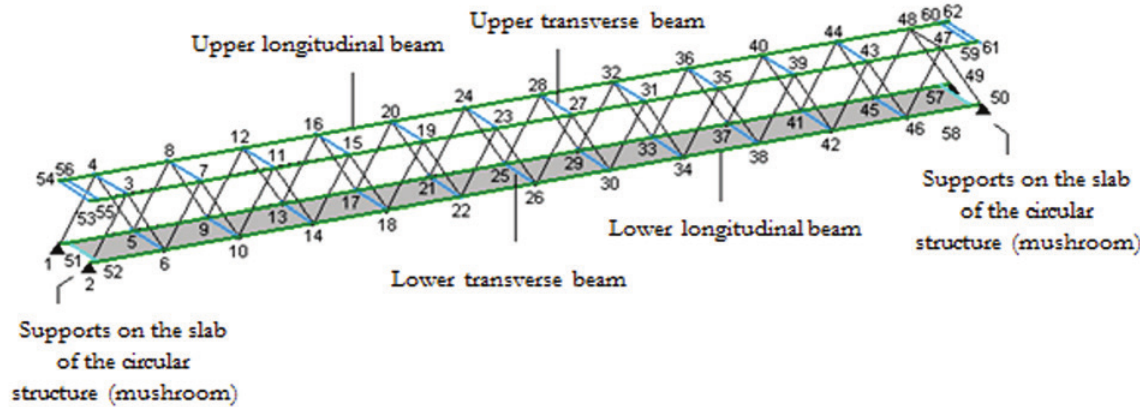
Discretization applied (modified from Gomes